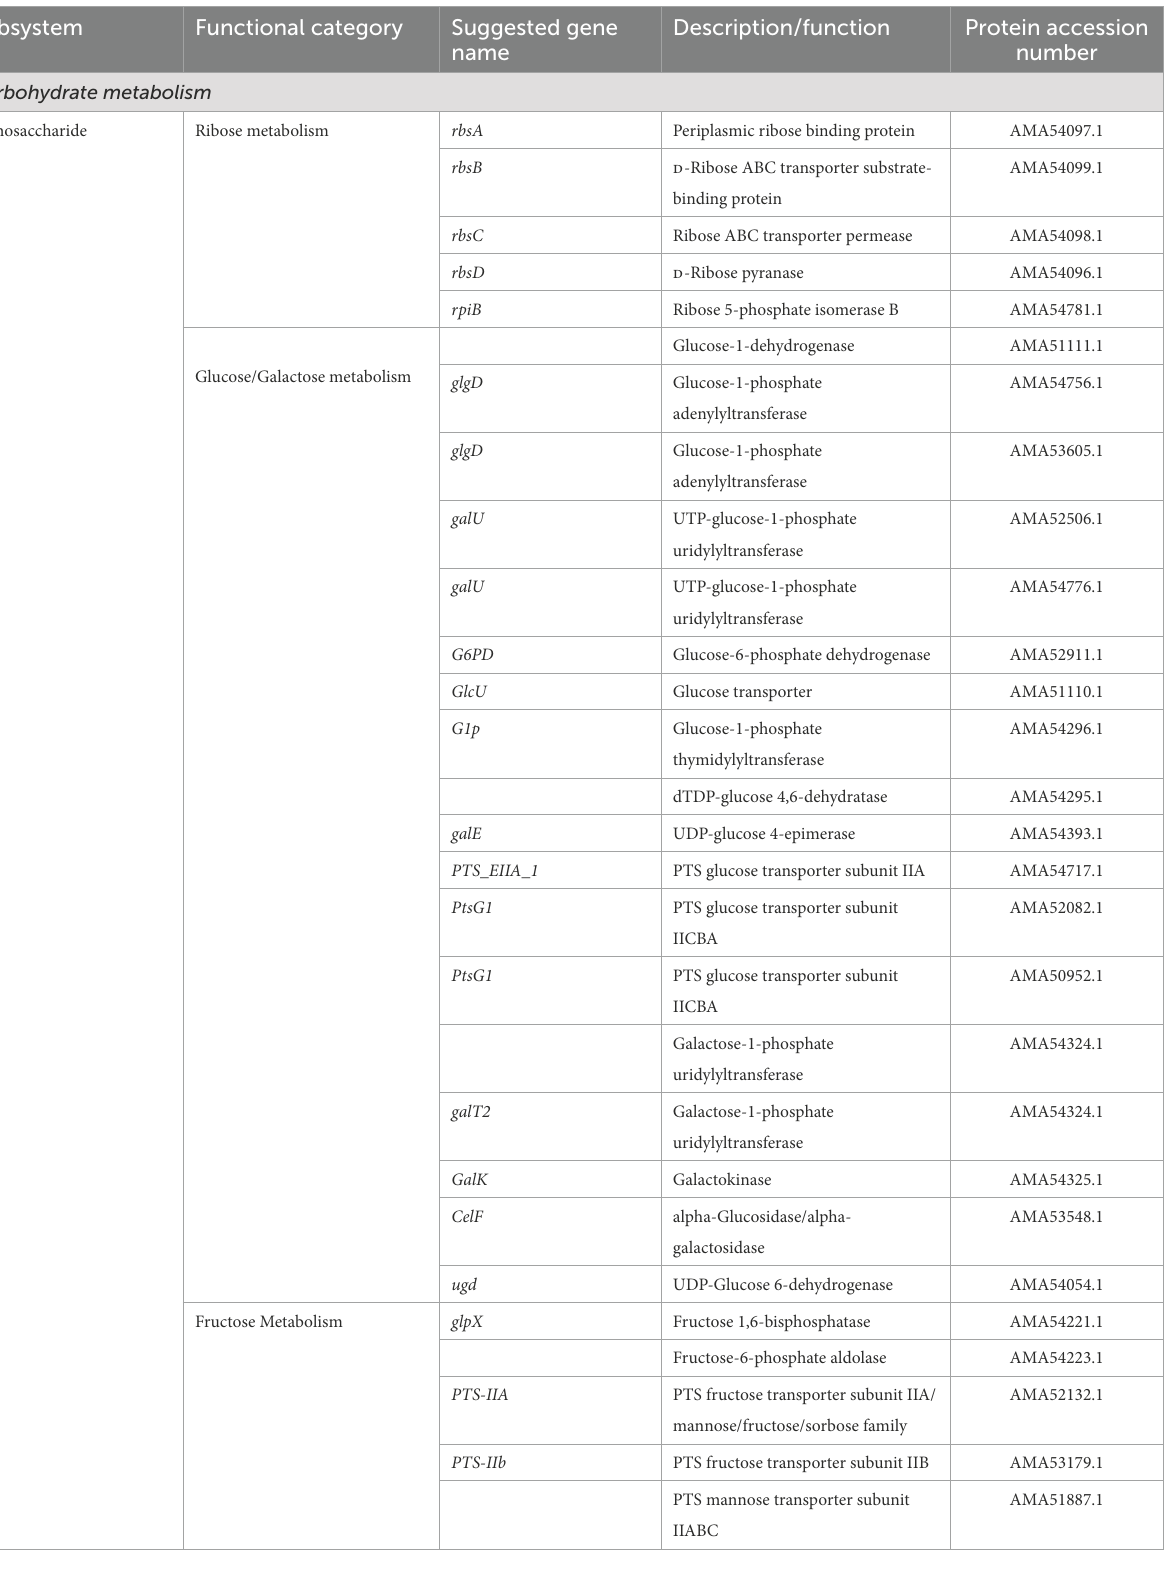
TABLE 3 Distribution of transporters and enzymes in DE111 ® that are potentially responsible for carbohydrate, protein, and lipid metabolism.